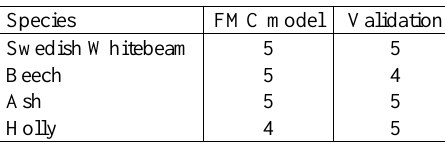
Table 1. Number of leaf samples collected.